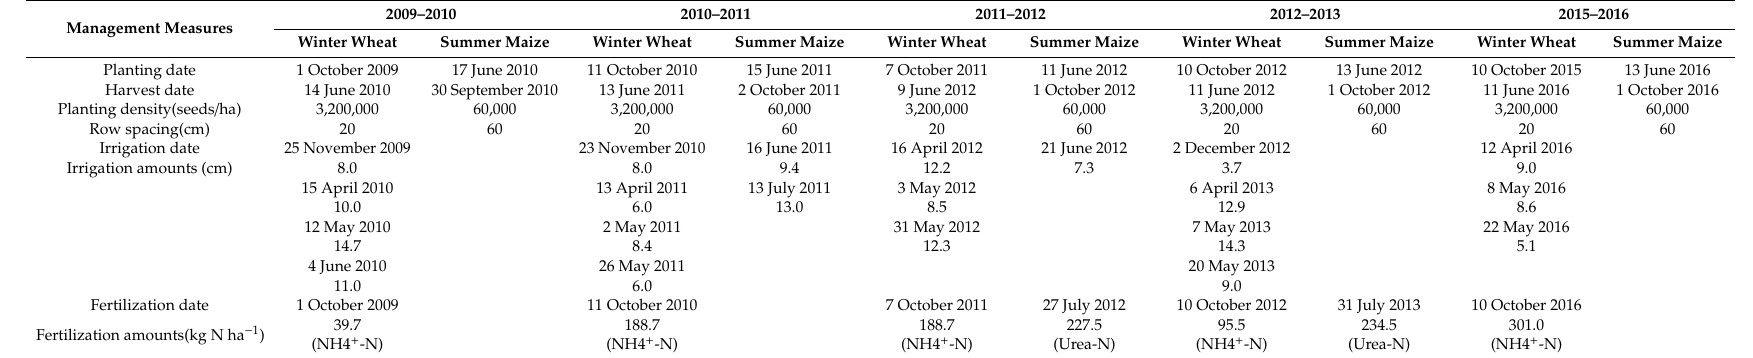
Table 2. Summary of field management practices in the cropping system of winter wheat and summer maize at the Luancheng Agro-Experimental Station (LAES) in the piedmont of the North China